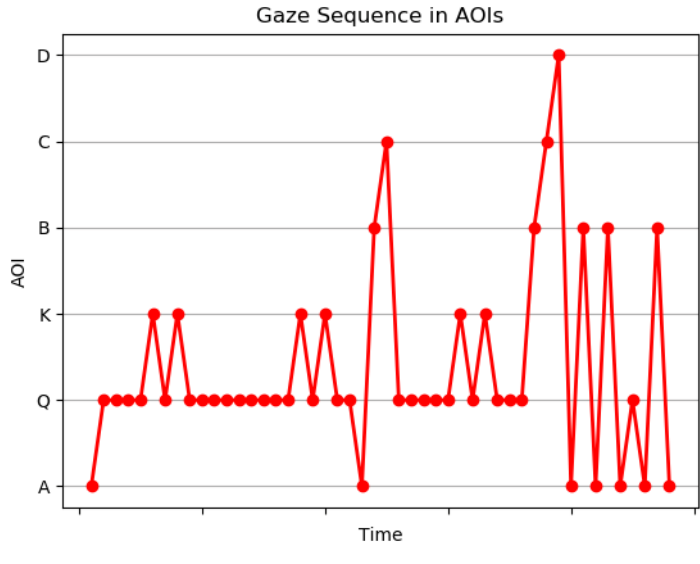
Figure 5. Gaze Sequence